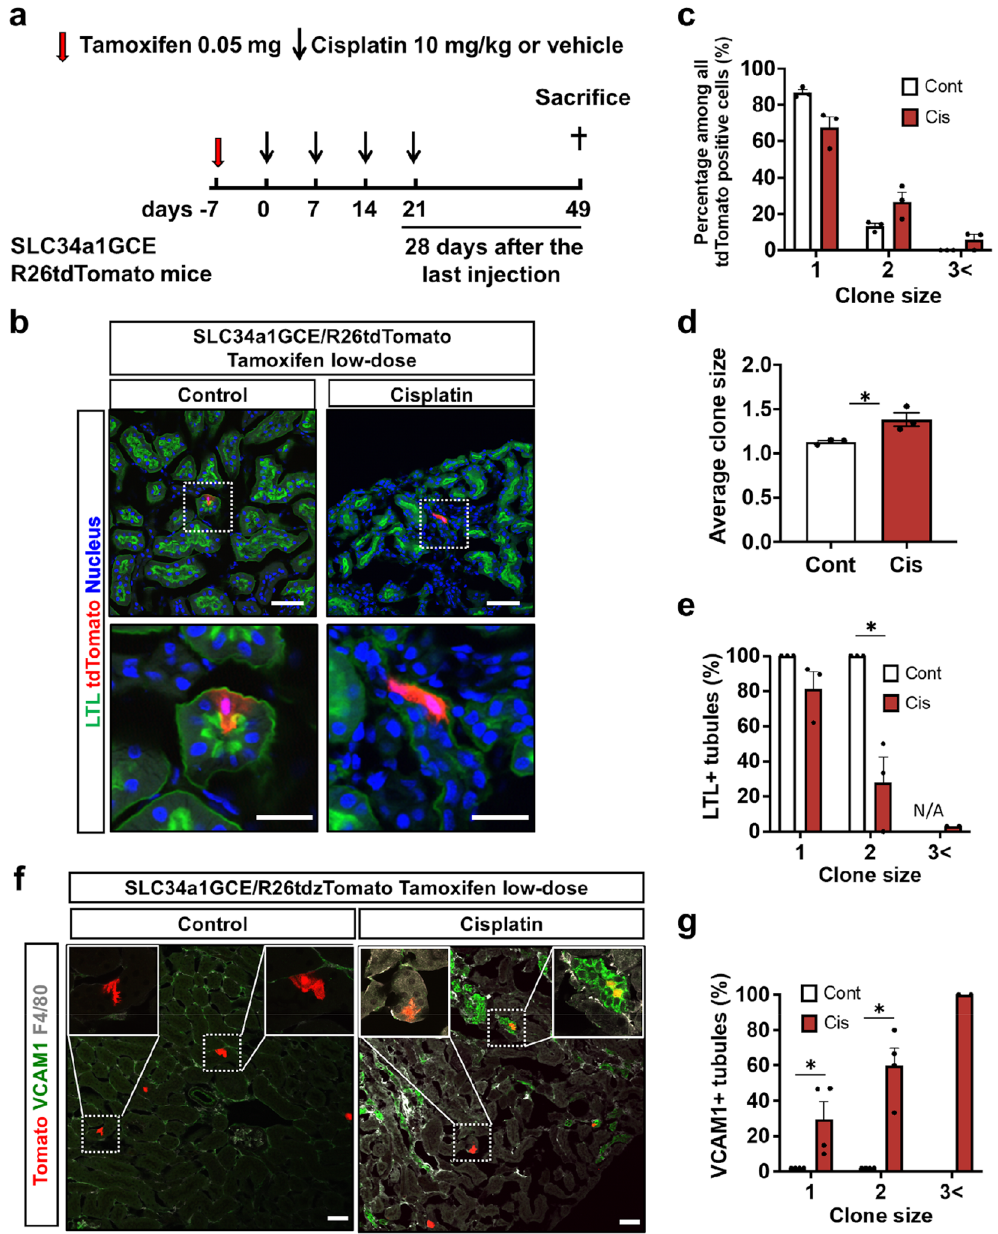
Figure 6. Clonal analysis of proximal tubular epithelial cells after repeated administration of 10 mg/kg of cisplatin. ( a ) Experimental scheme. Repeated administration of 10 mg/kg of cisplatin to the SLC34a1GCE R26tdTomato mice after labeling single proximal tubular epithelial cells by low-dose tamoxifen injection. ( b ) Representative images of tdTomato and immunostaining of LTL. Expansion of single tdTomato + clones in the cisplatin group. ( c , d ). Quantification of the clone size and its frequency. ( e ) Quantification of LTL + tubules by each clone size. ( f ) Representative images of tdTomato, and immunostaining of vcam-1 and F4/80. ( g ) Quantification of vcam-1 + tubules by each clone size. Data are the mean ± SE. * P < 0.05. Scale bar = 50 μm in LPF and 20 μm in